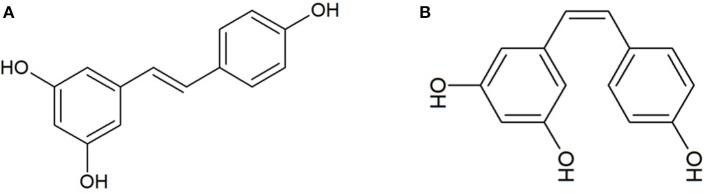
Resveratrol (C14H12O3). (A)
Trans-resveratrol; (B)
cis-resveratrol.